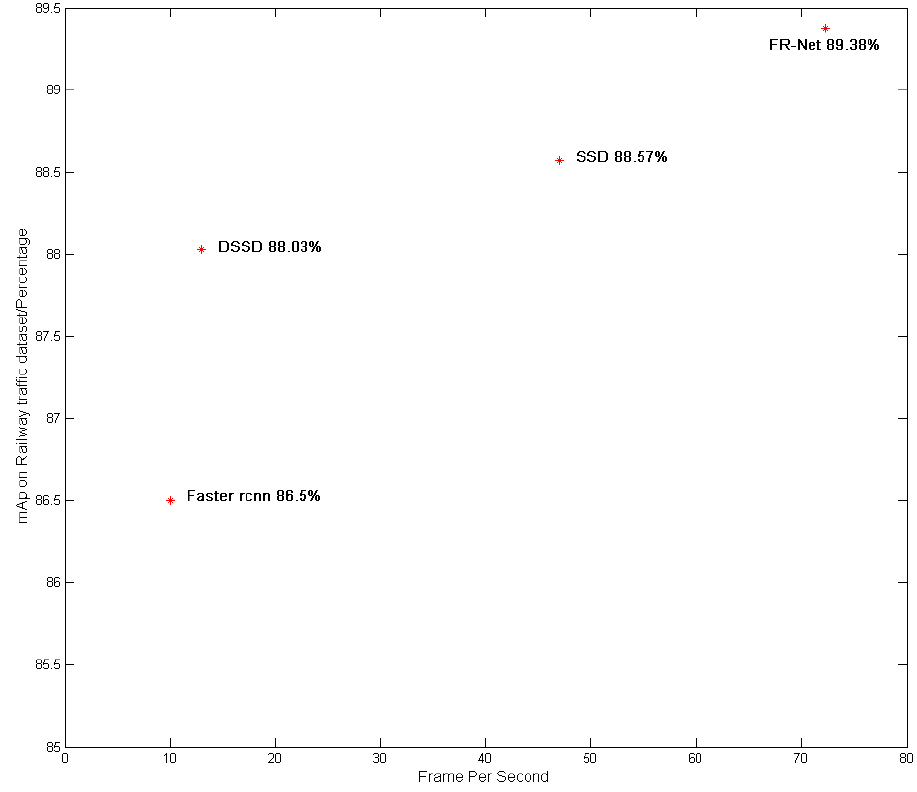
Figure 7. Speed and accuracy distribution with different methods. All the speeds were measured on Nvidia GeForce GTX1080Ti.